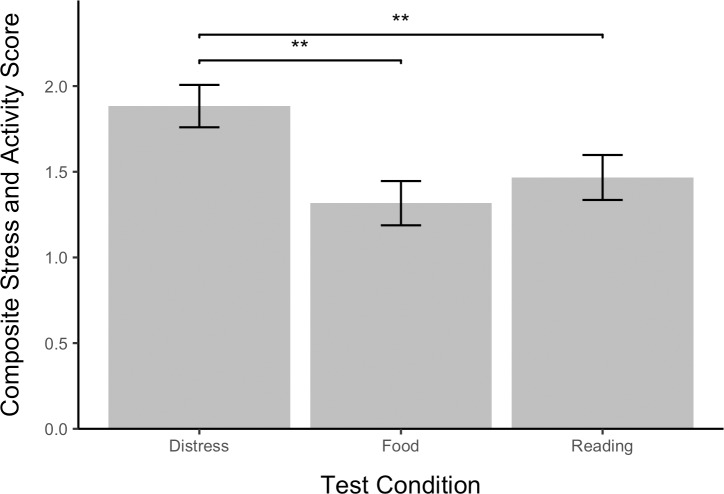
Stress and activity level by test condition.Positive and negative behavioral indicators of stress and activity were used to generate a composite score for each dog in each test. The occurrence of each behavior was treated as a binary outcome and all behaviors were weighted equally. Error bars show standard errors.